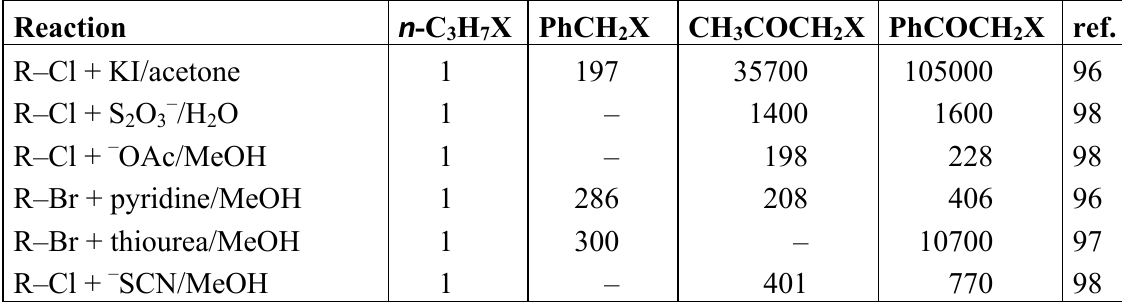
H X of α -Halocarbonyl Compounds 3 7